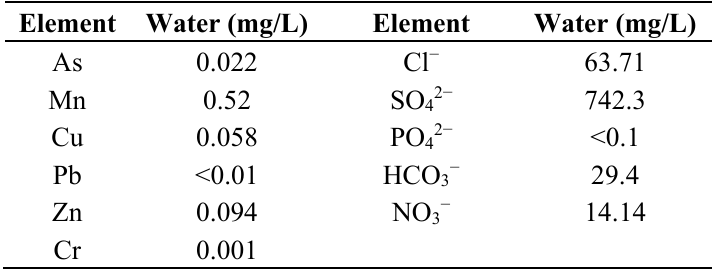
Table 4. The chemical composition of water